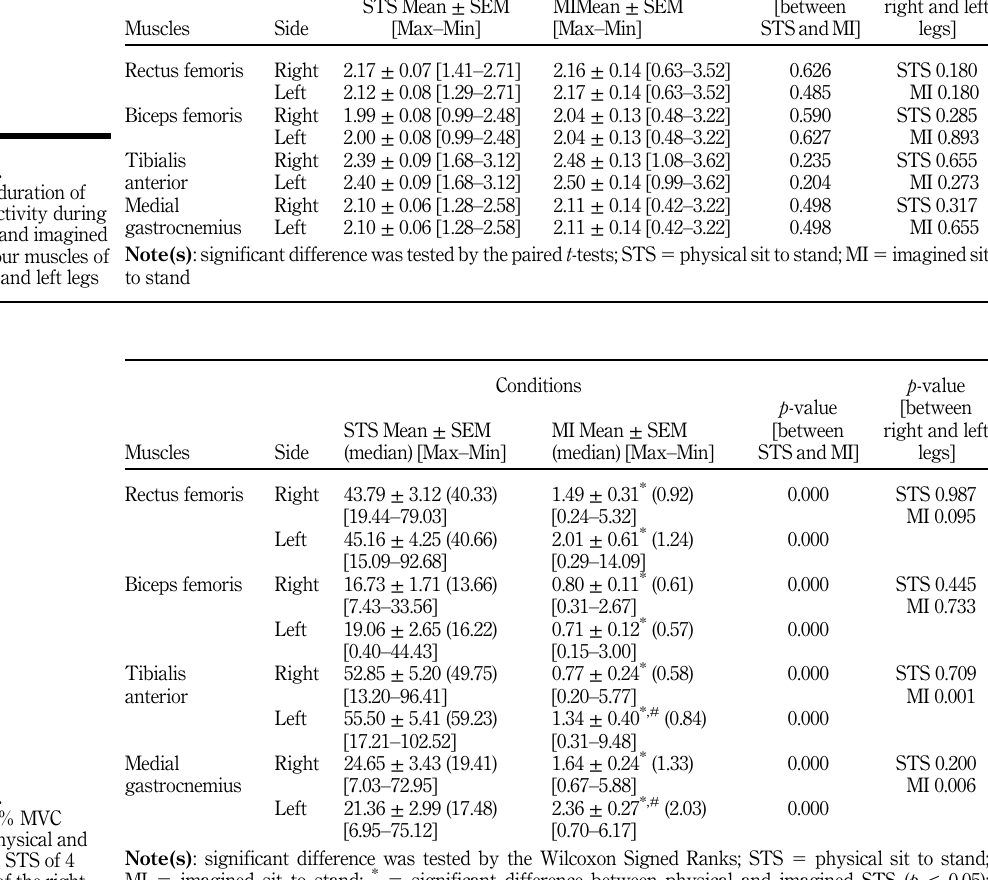
Table 4. Mean of % MVC during physical and imagined STS of 4 muscles of the right and left